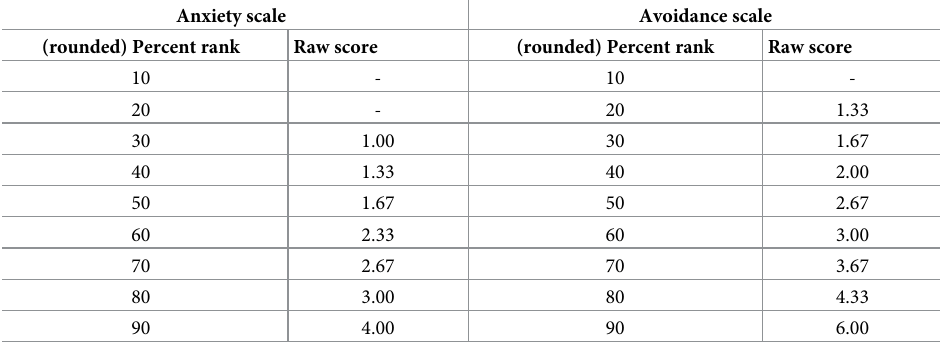
Table 9. Percent rank scores and T-values for the anxiety and the avoidance